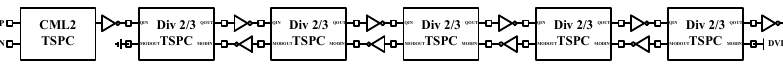
Figure 5. Divider chain topology.